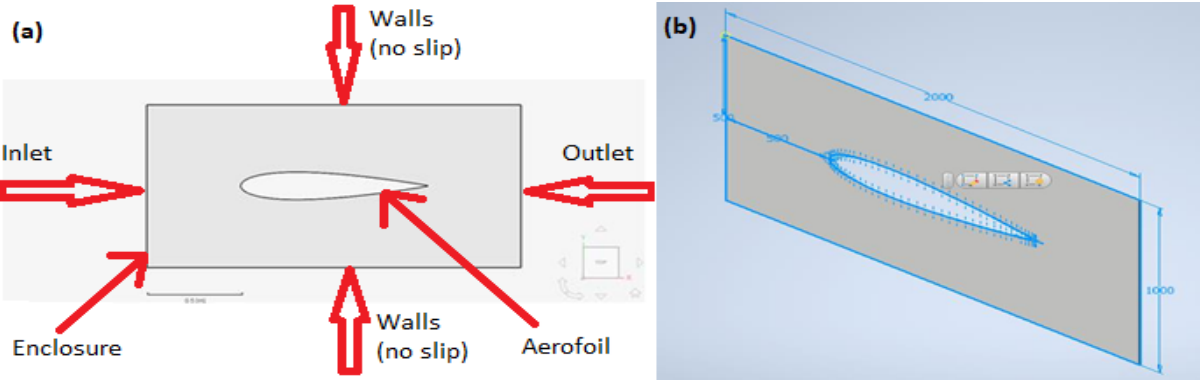
Figure 6. Flow Domain of the aerofoil in 2D, showing ( a ) boundary conditions, and ( b ) enclosure dimensions. Table 3. Parameters for the Initial Boundary Conditions.